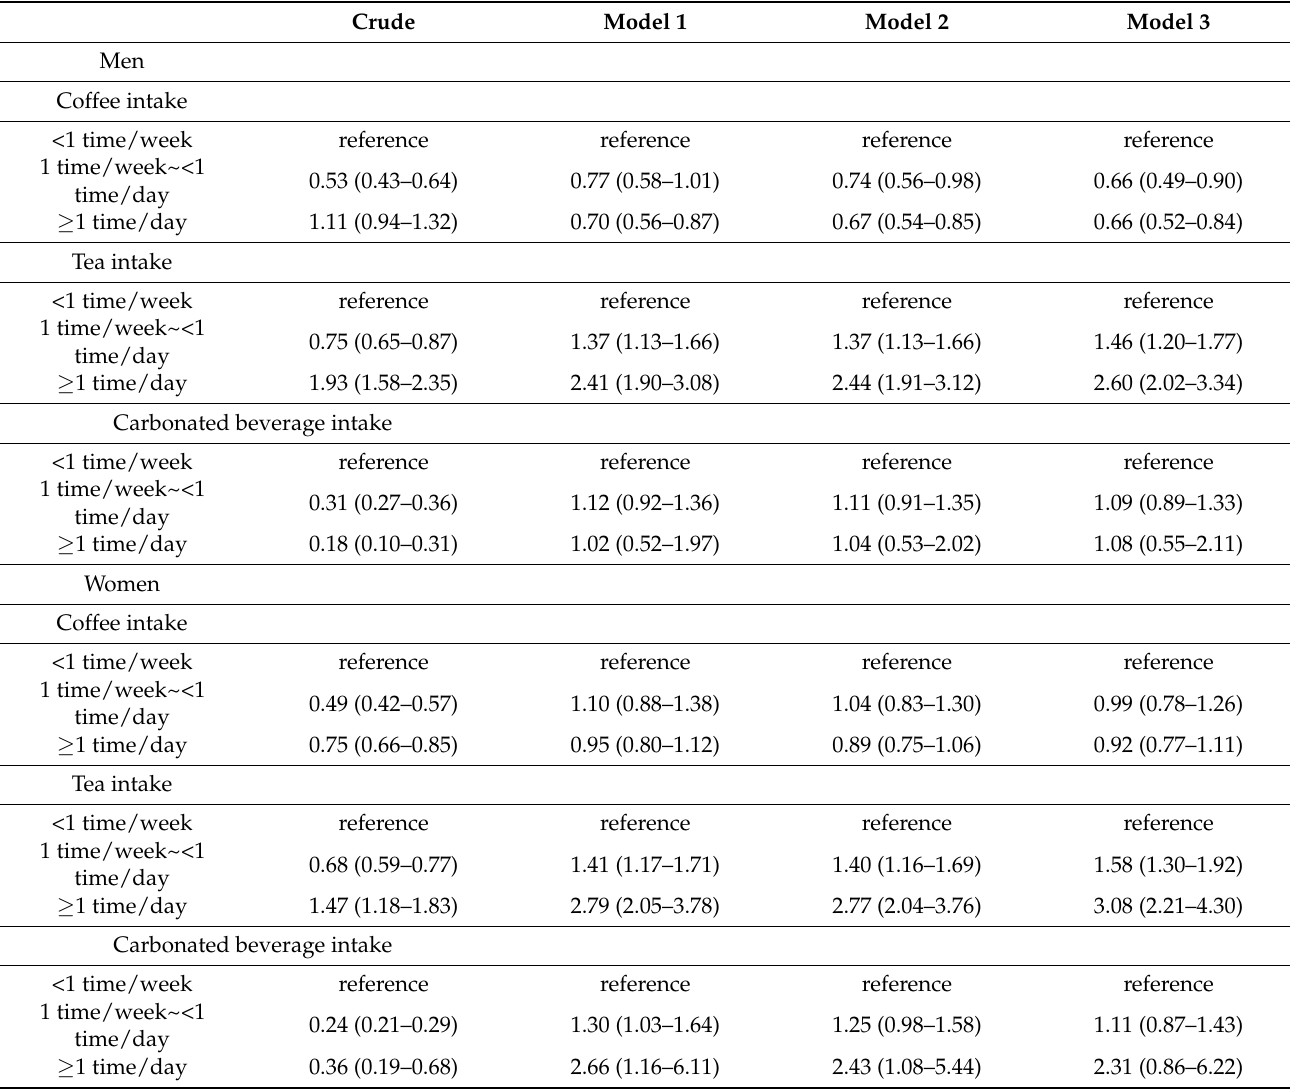
Table 1. Multivariable logistic regression for hypertension according to the frequency of intake of coffee, tea, and carbonated beverages.